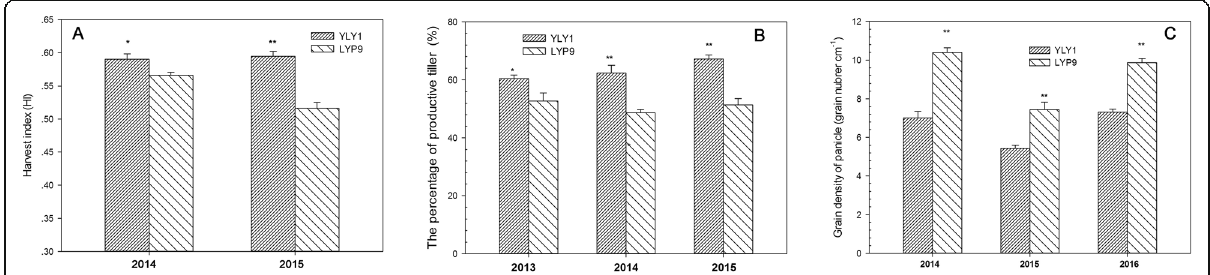
Fig. 10 The harvest indexes of YLY1 and LYP9 in 2014 and 2015 ( a ); the percentage of productive tillers in YLY1 and LYP9 in 2013, 2014, and 2015 ( b ); the grain density of panicle ( c ). “ *, ” “ ** ” represent significance levels of p = 0.05 and p = 0.01 levels, respectively. The bar represents the standard deviation of 5